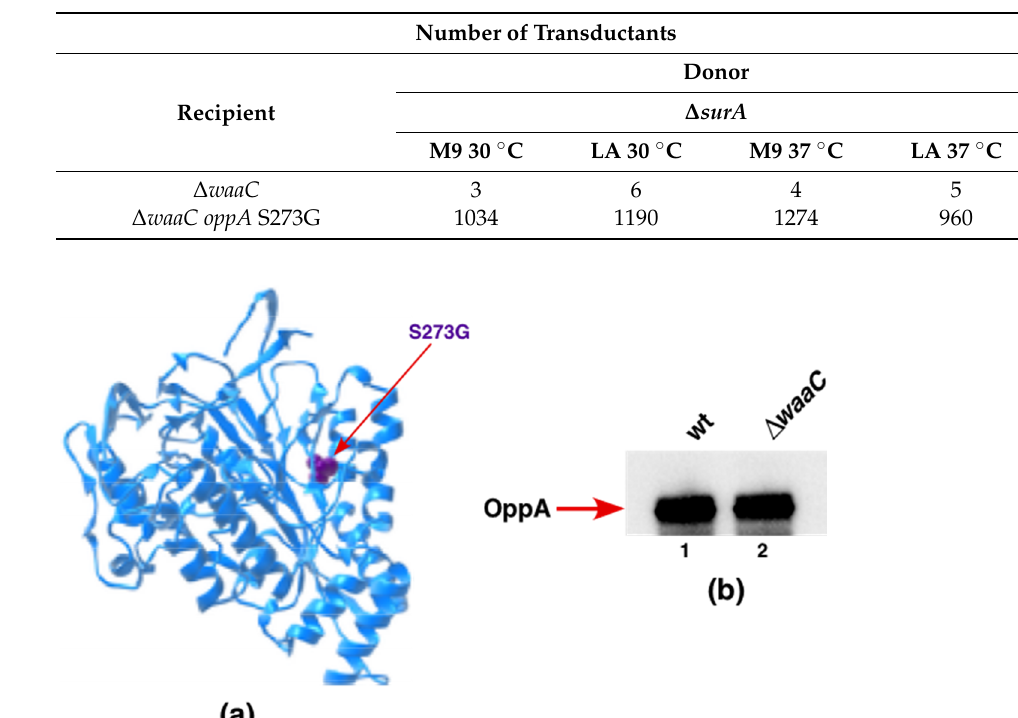
Table 4. Single amino exchange in the oppA coding sequence S273G allows for the construction of ∆ ( waaC eptB ) deletion. Determination of the viability of ∆ ( waaC surA ) derivatives in the presence or absence of oppA S273G suppressor mutation by bacteriophage-mediated transductions. Numbers depict the number of transductants using the equivalent amount of recipient.